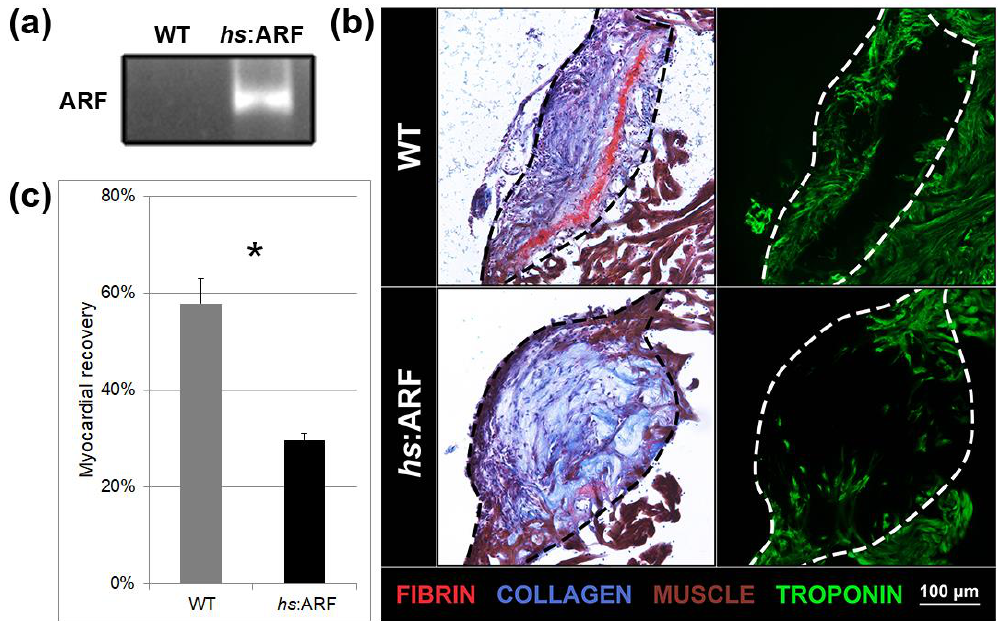
Figure 1. Induced Alternative Reading Frame (ARF) expression in hs :ARF fish suppresses cardiac regeneration. ( a ) Representative polymerase chain reaction (PCR) product of ARF expression from three experimental replicates of wild type (WT) and hs :ARF heart RNA on 15 dpi. The product run on gel electrophoresis shows ARF expression present in hs :ARF fish while absent in WT fish. ( b ) Acid Fuchsin Orange G (AFOG) and troponin staining of WT and hs :ARF heart cryosections on 15 days post-injury (dpi). The dotted lines demarcate the injury site. Red stains are for fibrin. Blue stains are for collagen. Brown stains are for muscle. Green stains are for troponin. ( c ) Myocardial recovery measured by troponin infiltration into the injury site. Infiltration quantified by imaging software shows decreased troponin in the injury site of hs :ARF fish compared to WT fish. N = 8 hearts. Results are shown as mean ± standard error. The * represents a statistically significant difference.